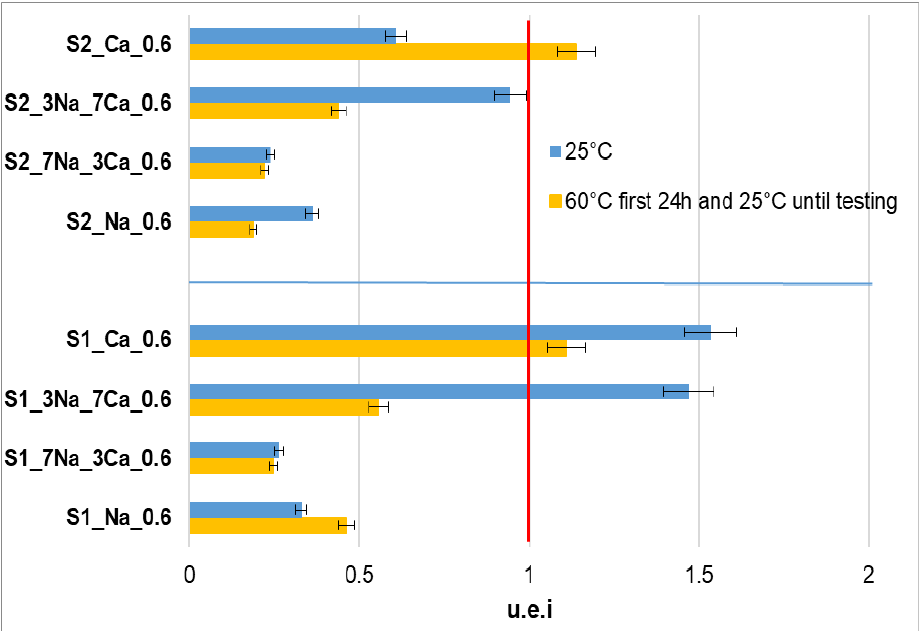
Figure 7. Underwater evolution index (u.e.i) for samples obtained with S1 respectively S2 glass powders stored the first 28 days at 25 °C (blue) or at 60 °C for the first 24h and then at 25 °C (orange) followed by curing underwater or air curing for the next 90 days.